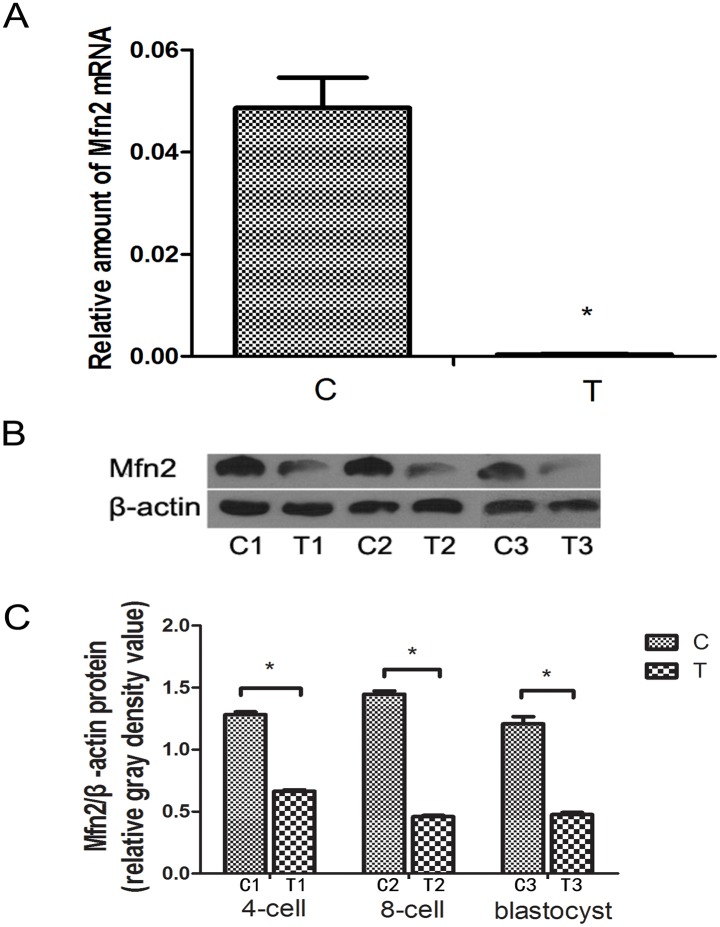
Mfn2 expression in mouse fertilized eggs after transfection.Mfn2 mRNA expression was detected by qPCR and its level is significant lower in T group than that in C group (A). Mfn2 protein levels were determined by Western blotting (B). The quantitation of Mfn2 protein levels. C1 and T1: 4 cells fertilized eggs, C2 and T2: 8 cells fertilized eggs, C3 and T3: blastocyst. *P<0.05. Data are means ± SD of 3 separate experiments (C).